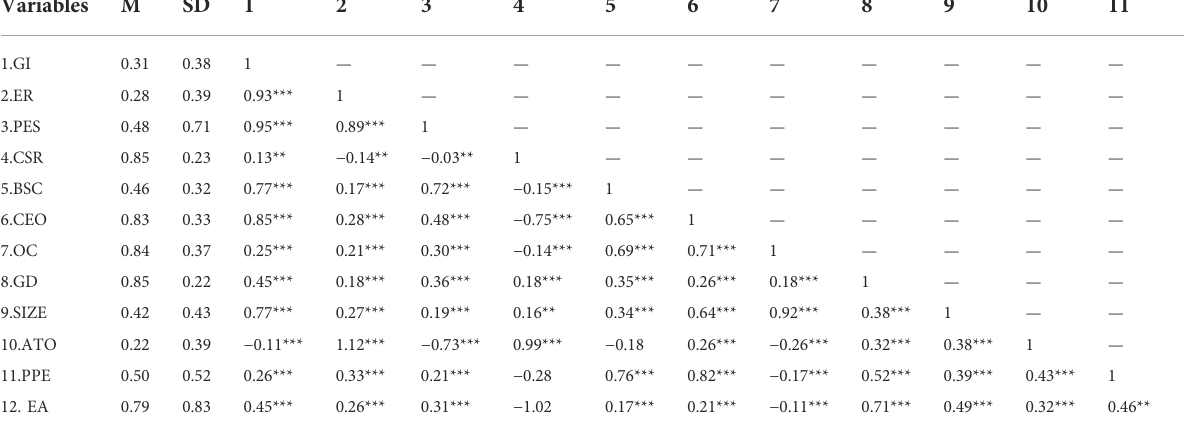
TABLE 1 Descriptive statistics and Pearson Correlation.